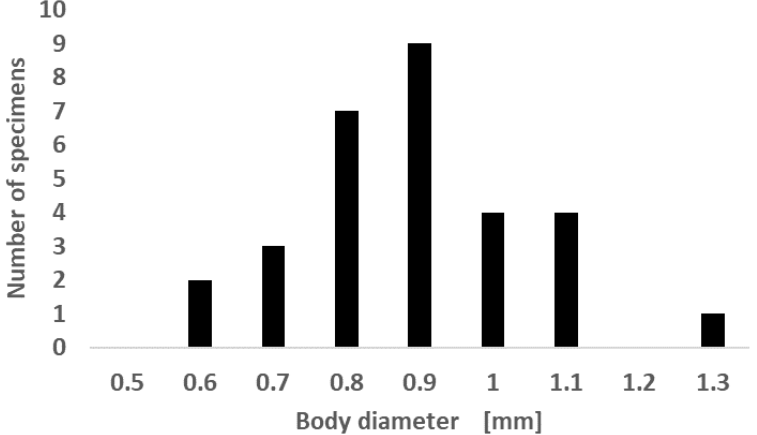
Figure 4. Distribution of body diameters of pheretimoid hatchlings collected from April to May 2016.